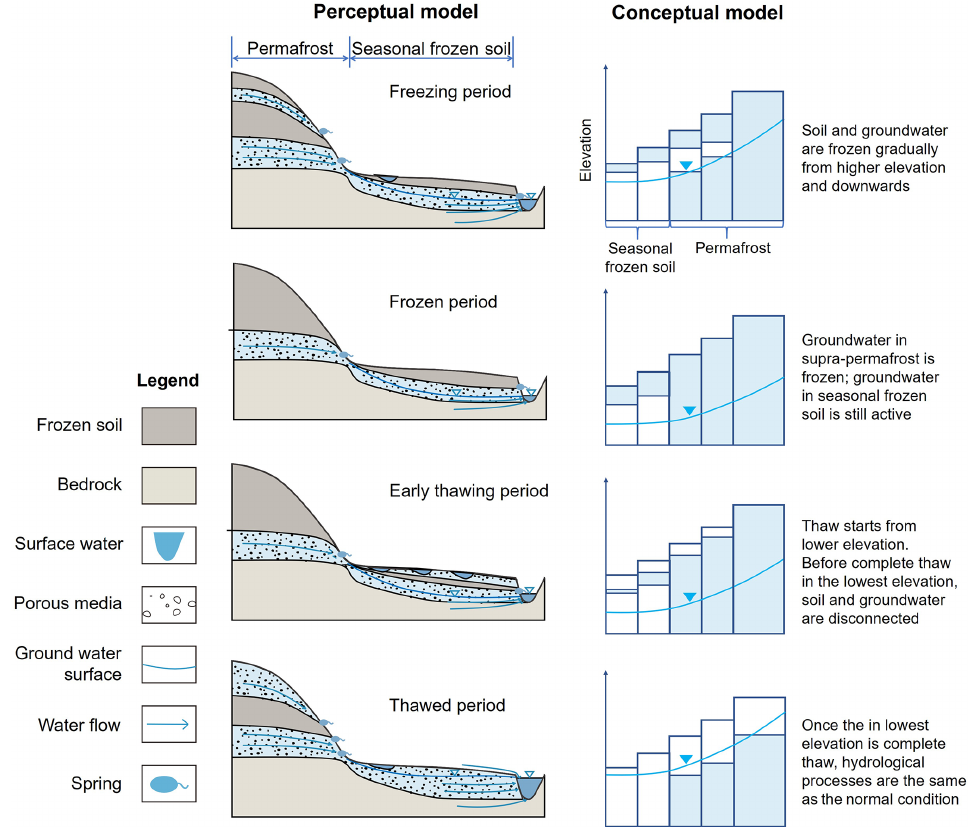
Figure 7. The perceptual and conceptual FLEX-Topo-FS frozen soil hydrological models. Table 1. The water balance and constitutive equations used in FLEX-Topo-FS model. In Eqs. (10), (11), and (12), the S u and S umax represent root zone reservoirs and their storage capacities in different landscapes, including vegetation hillslope ( S umax_V ), alpine desert ( S umax_D ), and riparian regions ( S umax_R